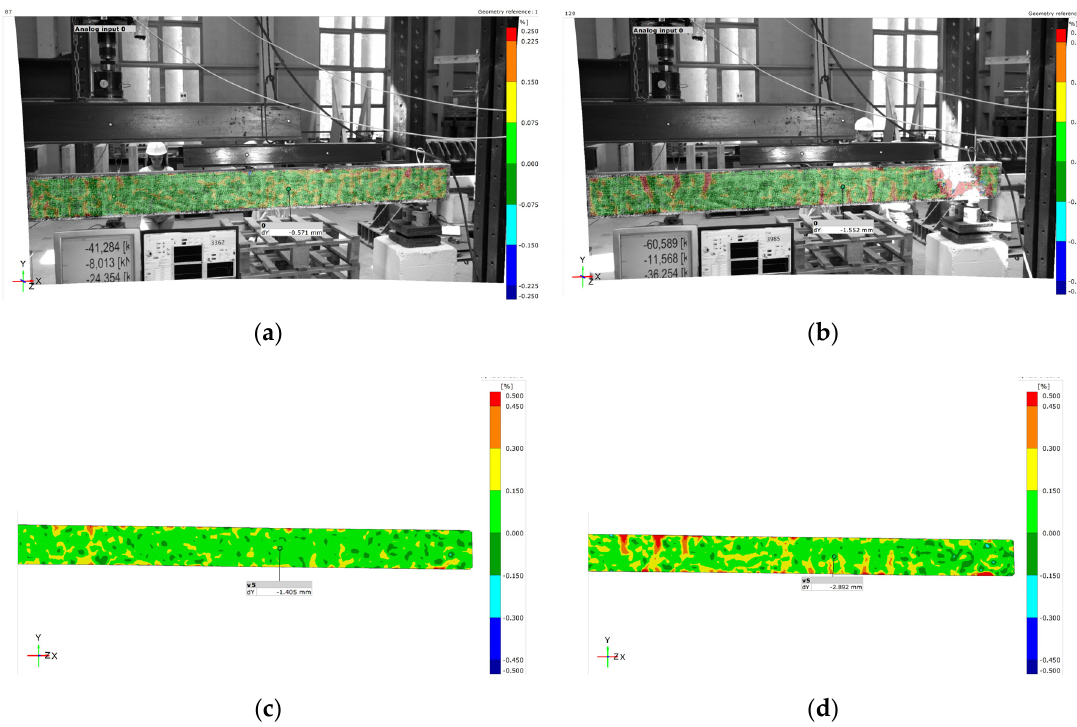
Figure 19. Deformations of beam sections at the time of cracking: ( a ) at the support section in Beam No. 1, ( b ) at the span section in Beam No. 1, ( c ) at the support section in Beam No. 2, ( d ) at the span section in Beam No. 2.